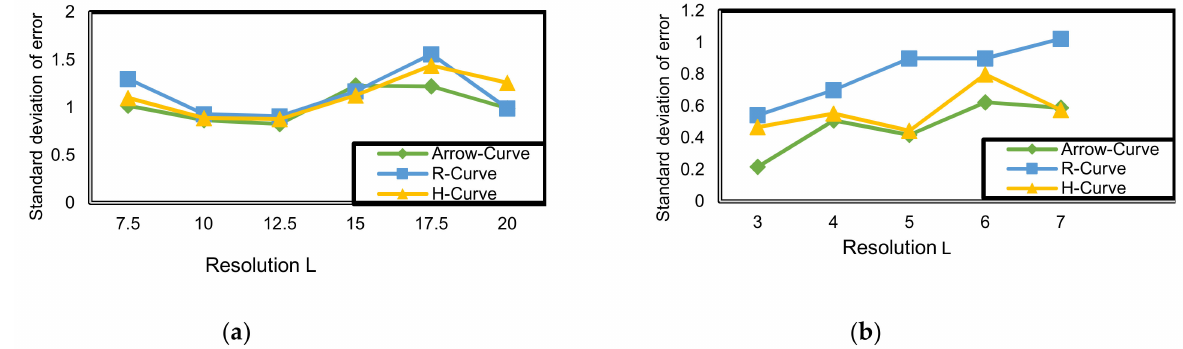
Figure 21. Standard deviation of error (SDE) corresponding to resolution (L) in Arrow-Curve model, R-Curve path model, and H-Curve: ( a ) outdoor environment; ( b ) indoor